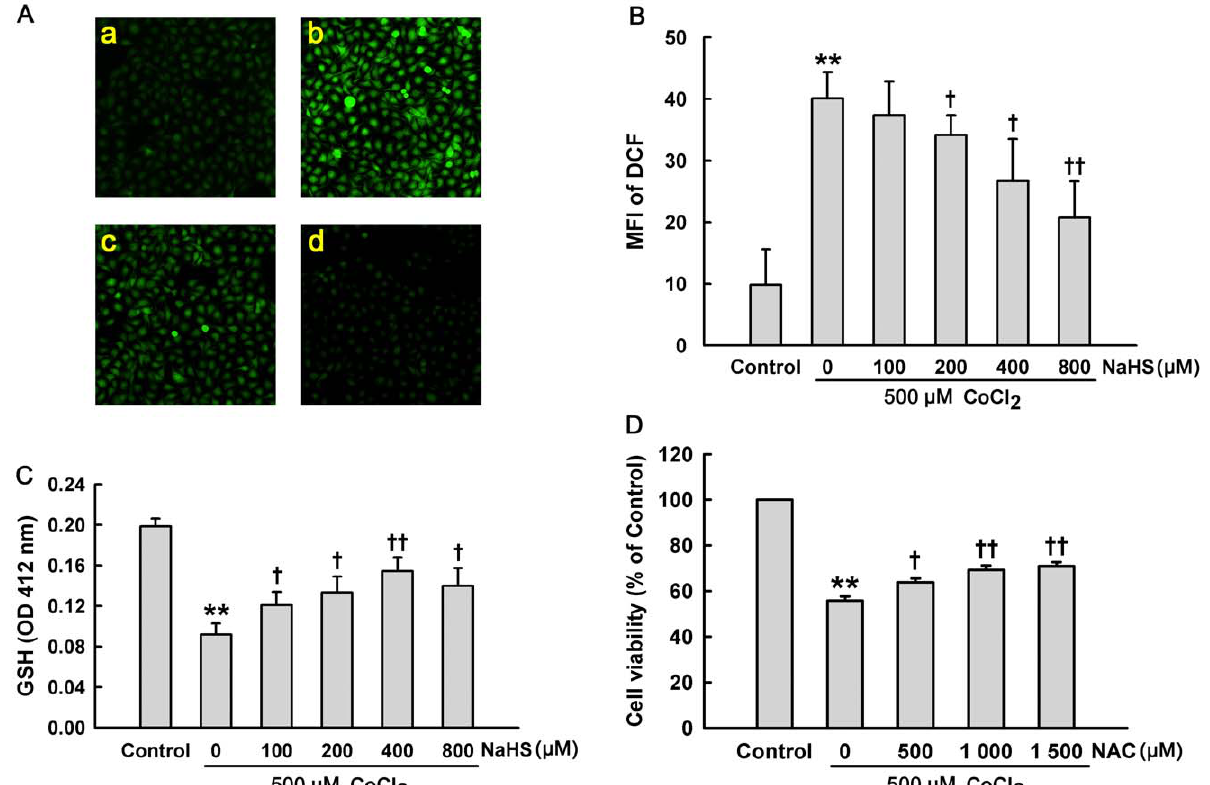
Figure 2. H 2 S reduces CoCl 2 -elicited oxidative stress in HaCaT cells. ( A ) a–d DCF staining followed by photofluorography to observe intracellular ROS level. (a) Control group. (b) HaCaT cells exposed to 500 m M CoCl 2 for 2 h. (c) HaCaT cells were pretreated 400 m M NaHS for 30 min before exposure to CoCl 2 at 500 m M for 2 h and (d) HaCaT cells were treated with 400 m M NaHS for 30 min followed by 2 h culture. ( B ) HaCaT cells were exposed to 500 m M CoCl 2 for 2 h in the absence or presence of pre-incubation with the indicated concentrations of NaHS for 30 min. Quantitative analysis of the mean fluorescence intensity (MFI) of DCF with Image J 1.41o software. ( C ) HaCaT cells were exposed to 500 m M CoCl 2 for 24 h in the absence or presence of pre-incubation with the indicated concentrations of NaHS for 30 min. The intensity of TNB (indicating GSH content) was measured at 412 nm with a microplate reader. ( D ) HaCaT cells were exposed to 500 m M CoCl 2 for 24 h in the absence or presence of pre-incubation with NAC at the indicated concentrations for 60 min. Cell viability was measured by CCK-8 assay. Data were shown as the mean 6 SE. ** P , 0.01 compared with control group. + P , 0.05, ++ P , 0.01 compared with CoCl 2 treatment group.